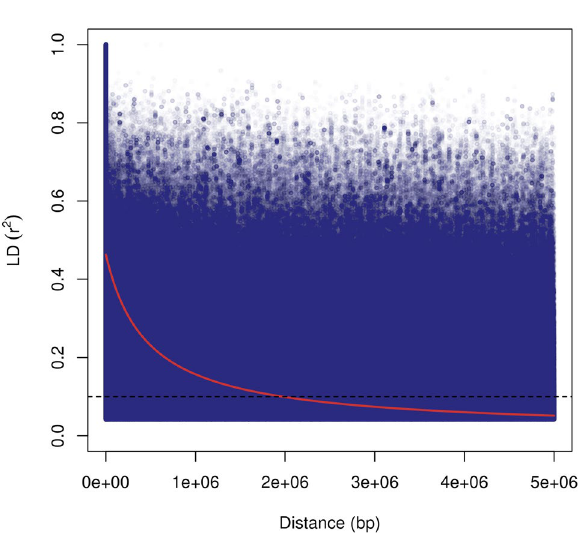
Figure 1. Factorial maps generated in the two hierarchical clustering on principal components (HPCP) analyses using BLUP values. ( a ) Factorial map of HCPC performed using the SCYLV titer determined by RT-qPCR. A division into three clusters (Q1, Q2 and Q3) was considered. ( b ) Factorial map of HCPC performed using SCYL symptom severity and SCYLV titer determined by RT-qPCR. A division into three clusters (SQ1, SQ2 and SQ3) was considered.